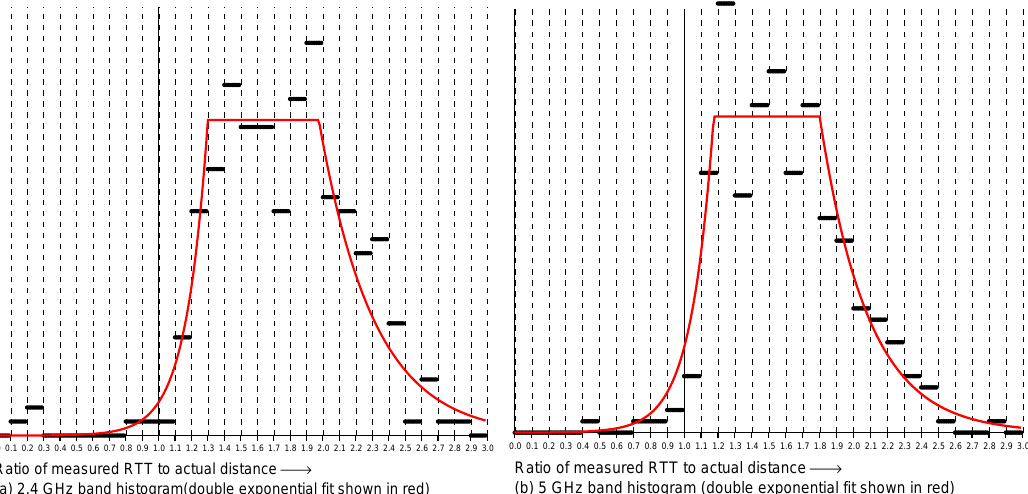
Figure 4. Histograms of ratios of RTT measurements to actual distances. Most measurements are larger than the actual distance, some twice as large or more: ( a ) 2.4 GHz band and ( b ) 5 GHz band. Coarse double-exponential fits shown in